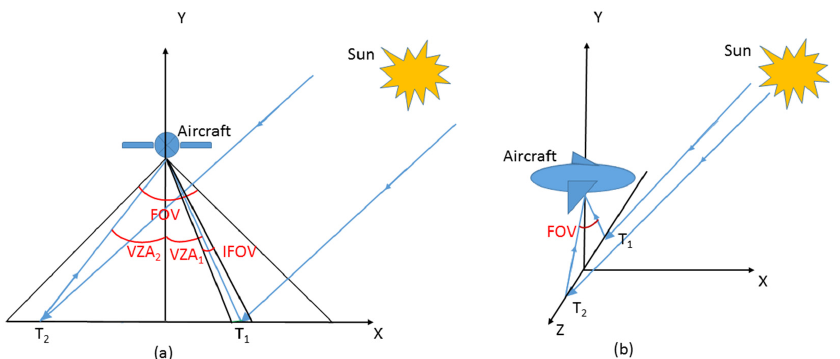
Figure 2. Flight lines over the study area on 25 July 2012. Flights marked in blue are parallel to the solar principal plane; those in red are perpendicular to the solar principal plane.